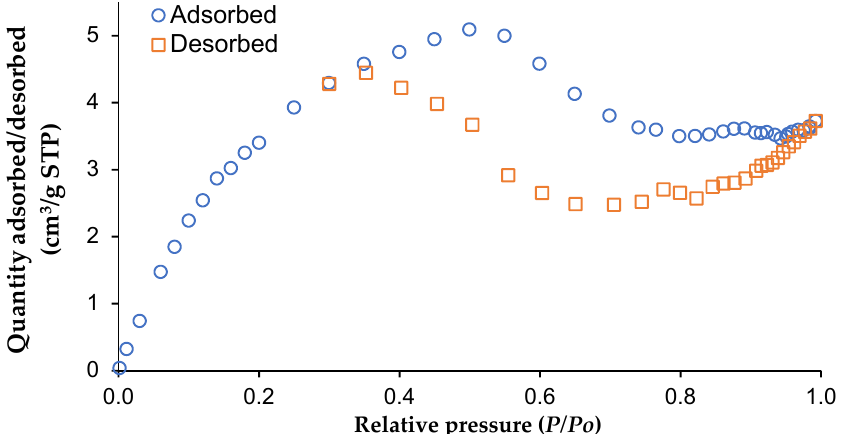
Figure 3. Nitrogen adsorption and desorption isotherm of CNCs using BET analysis.